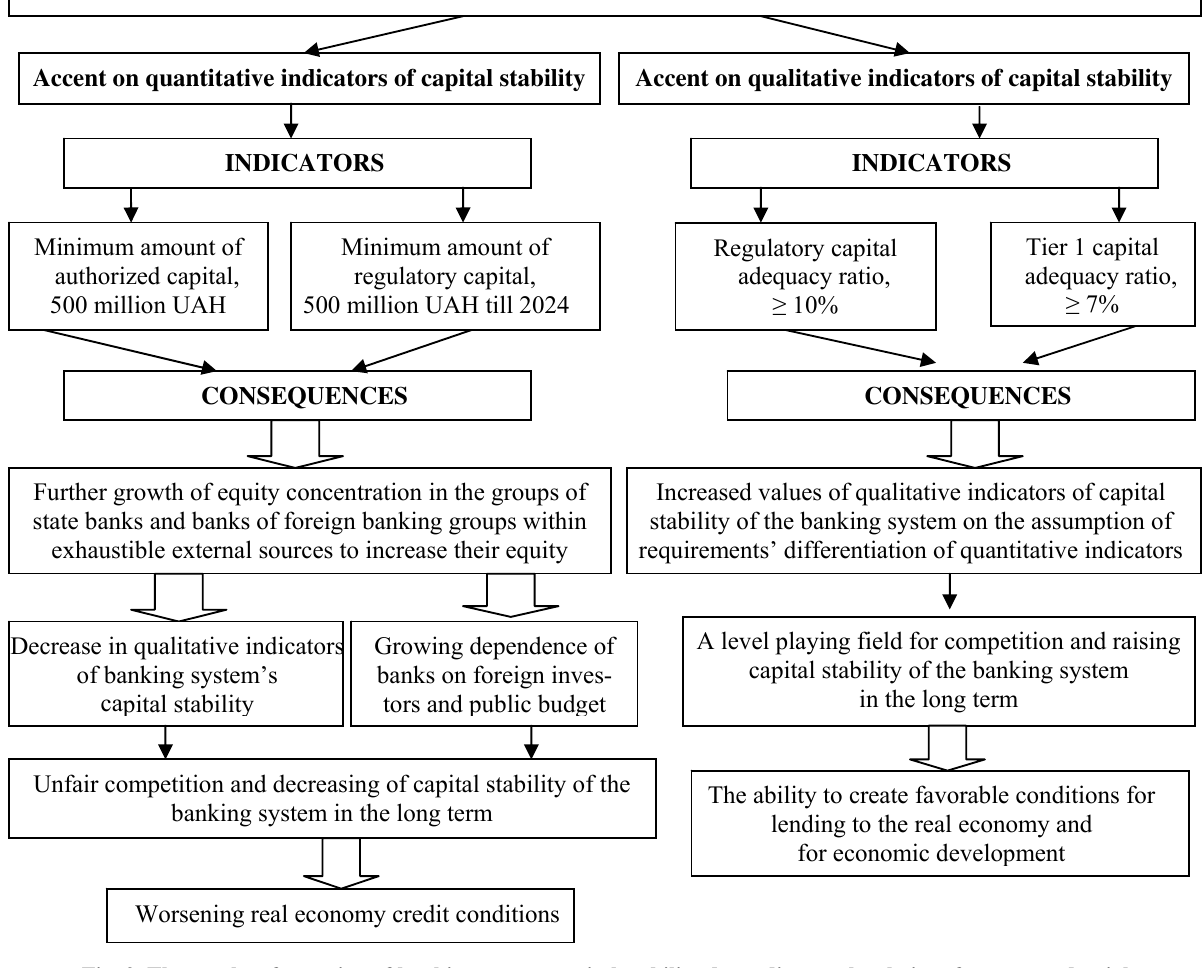
Fig. 2. The results of ensuring of banking system capital stability depending on the choice of macroprudential requirements’